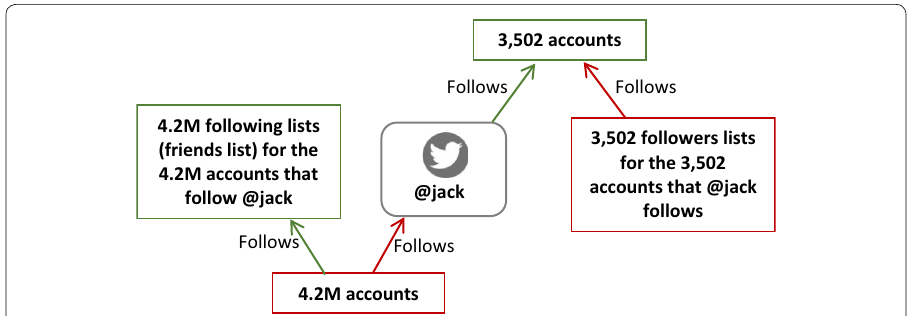
Fig. 1 Lists examined when scoring the follower/following relationship between two